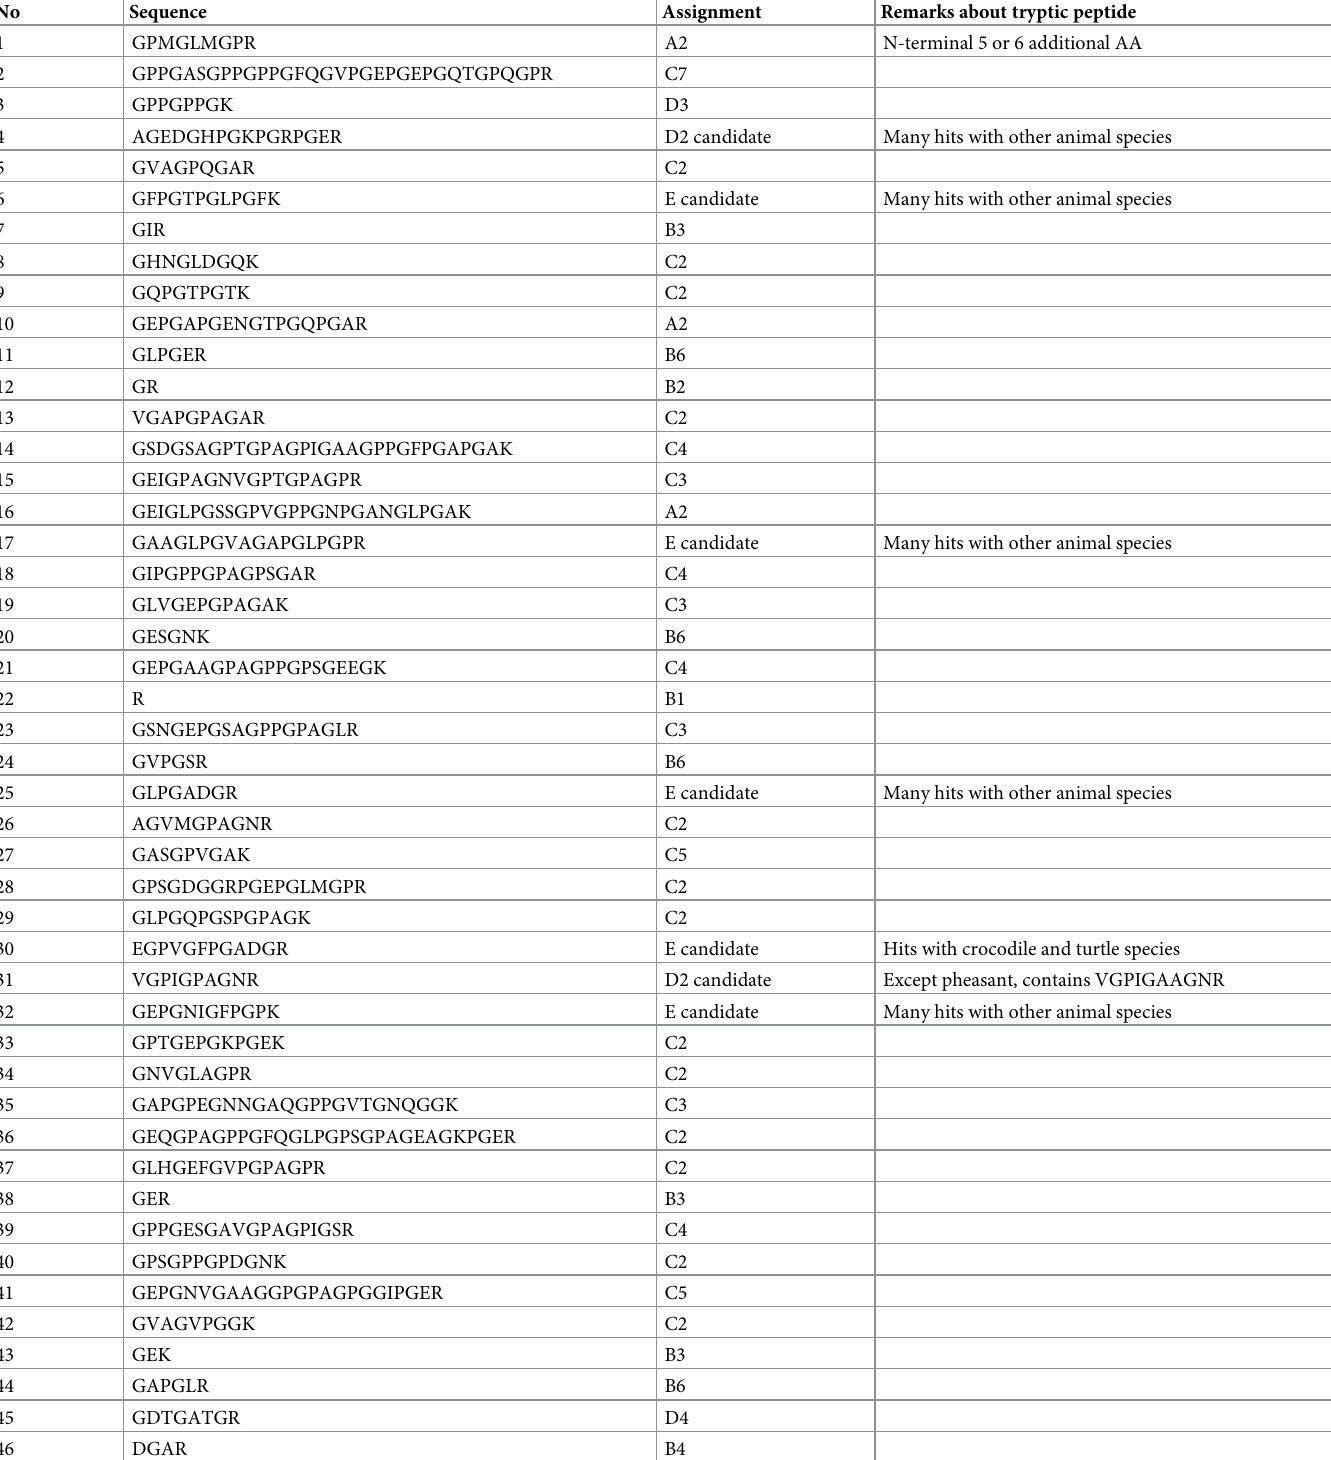
Table 2. Results of the theoretical assessment of tryptic peptides. The peptides were derived from the constructed common bird ancestor collagen 1 α 2 GXY domain. Assignments are explained in the main